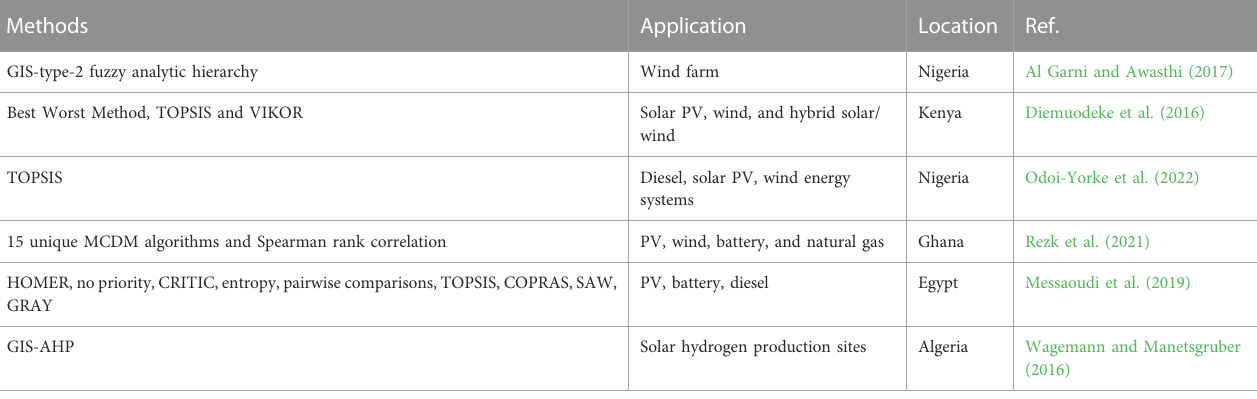
TABLE 6 Application of GIS in energy panning and mini-grid site